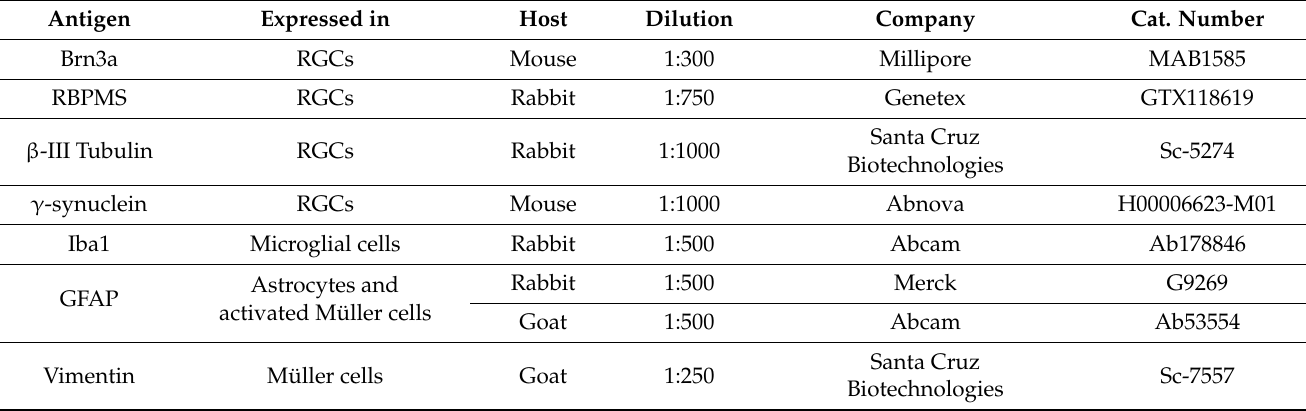
Table 1. Primary antibodies